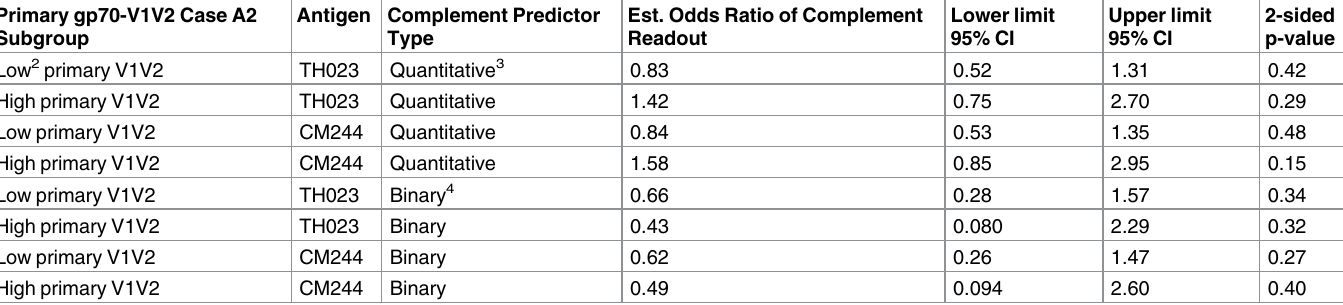
Table 5. Complement readout logistic regression model correlates of risk assessment within vaccine recipient subgroups with Low and High pri- mary gp70-V1V2 Case A2 binding antibodies 1